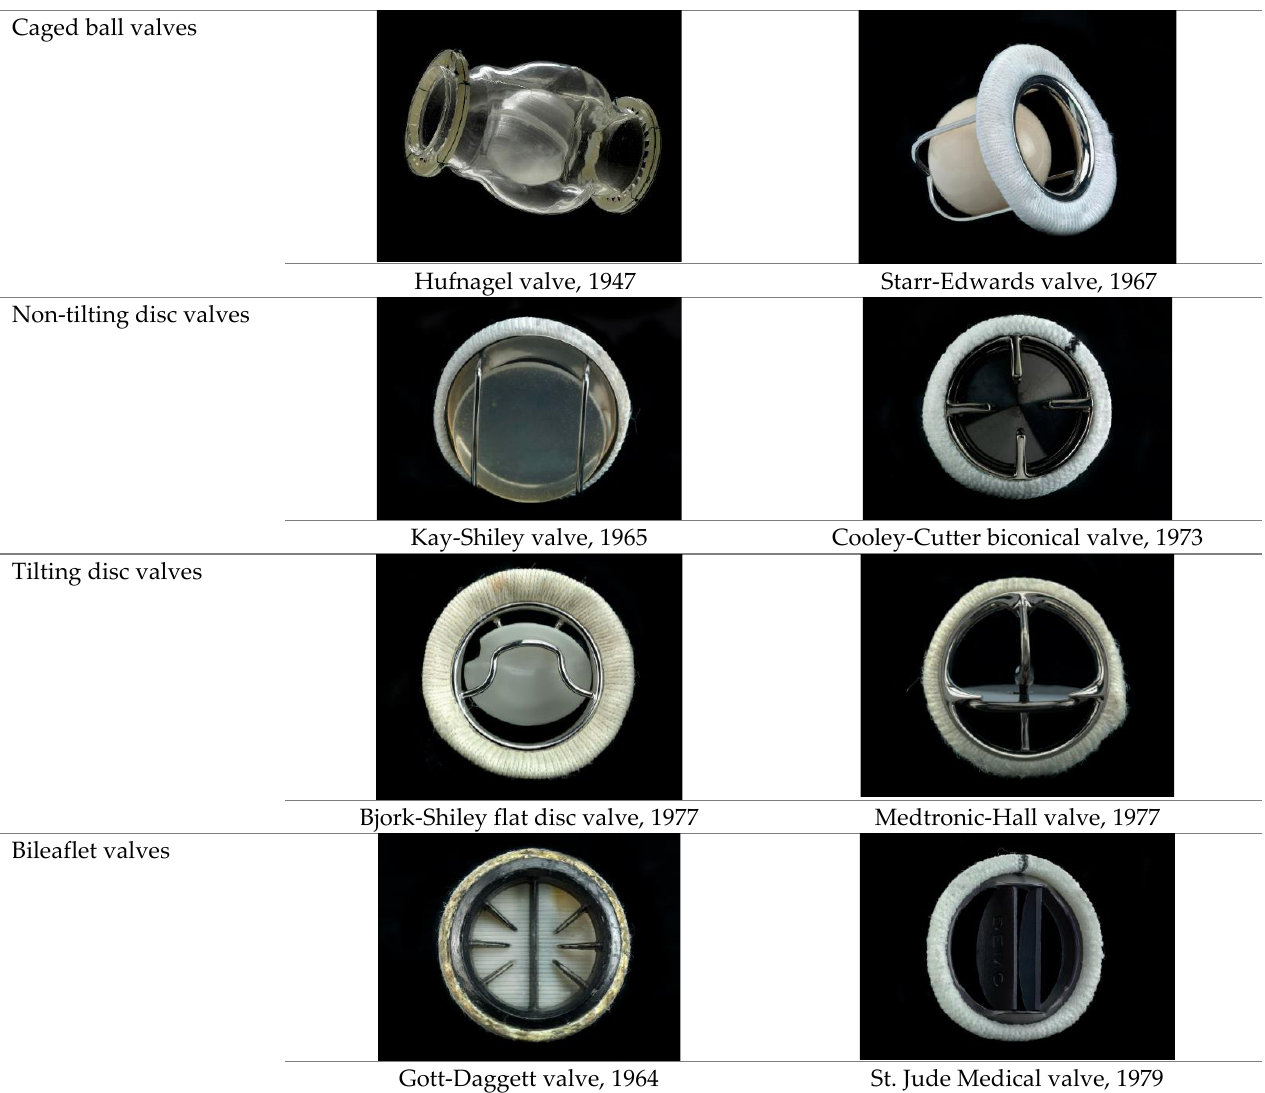
Figure 3. Evolution of mechanical valves. Reprinted with permission from ref. [68]. Copyright 2022, Smithsonian Institution.